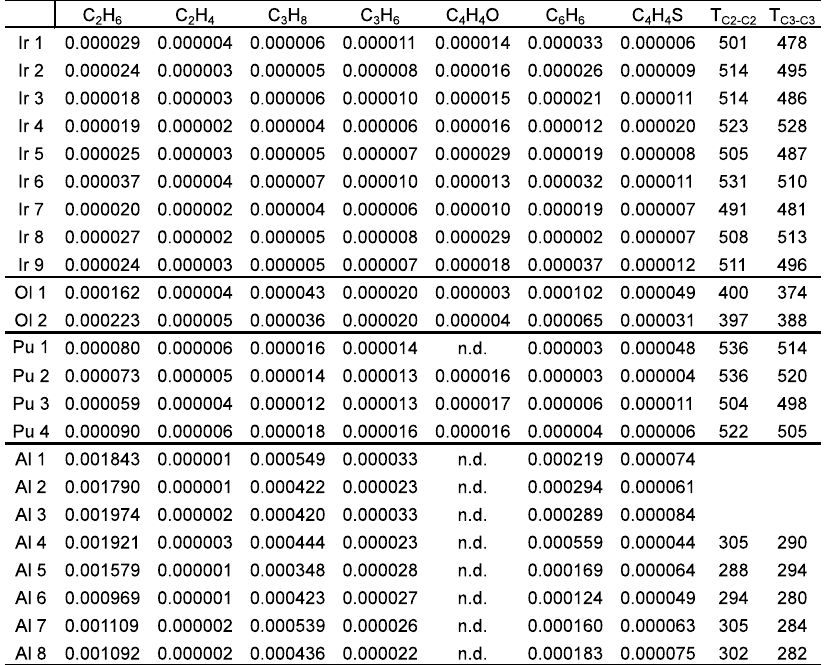
H , C H , C H , C H , C H O, C H S and C H ) of fumaroles from the 2 6 2 4 3 8 3 6 4 4 4 4 6 6